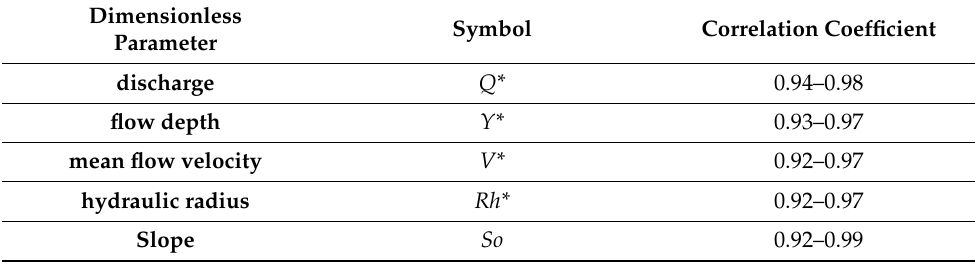
Table 3. Correlation coefficients for simple linear regression with bedload transport